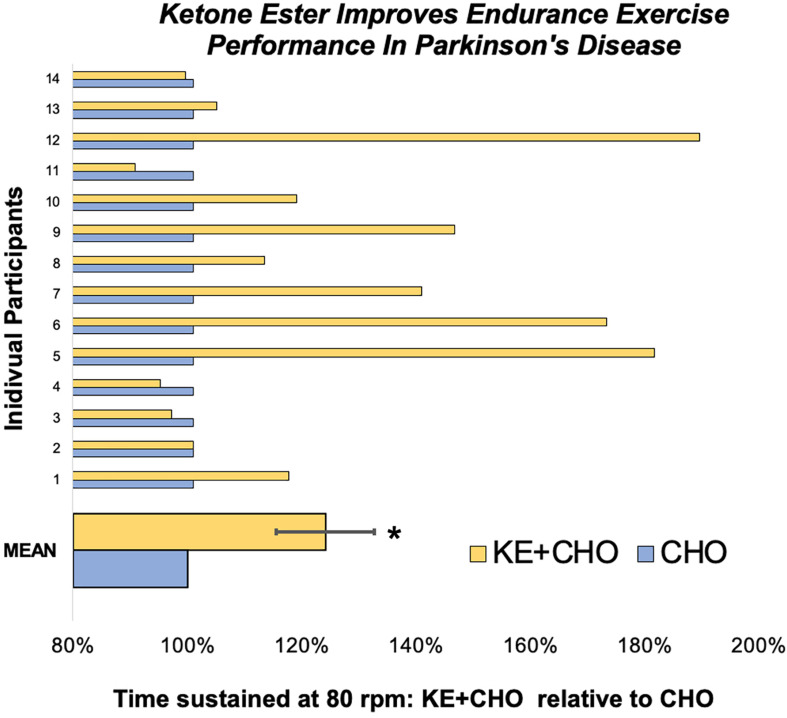
Endurance exercise test performance. On the endurance test, participant cycled for 24 ± 9% longer at 80 rpm following the ketone ester plus carbohydrate (KE+CHO) drink relative to performance following the isocaloric carbohydrate (CHO) drink. Data are expressed as performance following the KE+CHO drink divided by performance following the CHO drink, where performance is defined as the length of time participants could sustain 80 rpm. * indicates p = 0.027 as determined by Wilcoxon test.